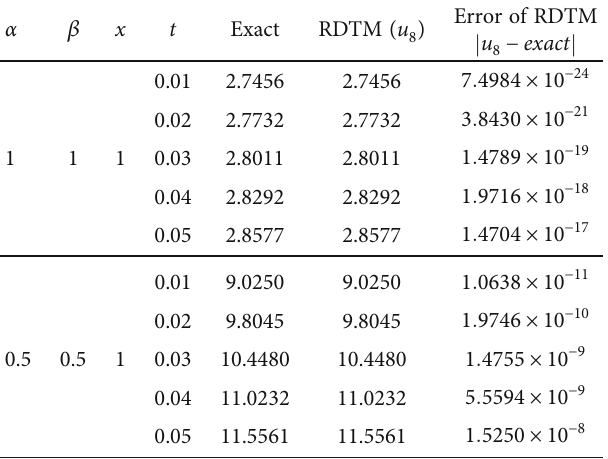
Table 3: Eighth-order approximate solution by RDTM of Example 3 for di ff erent values of α , β , and t and comparison with the exact solution.